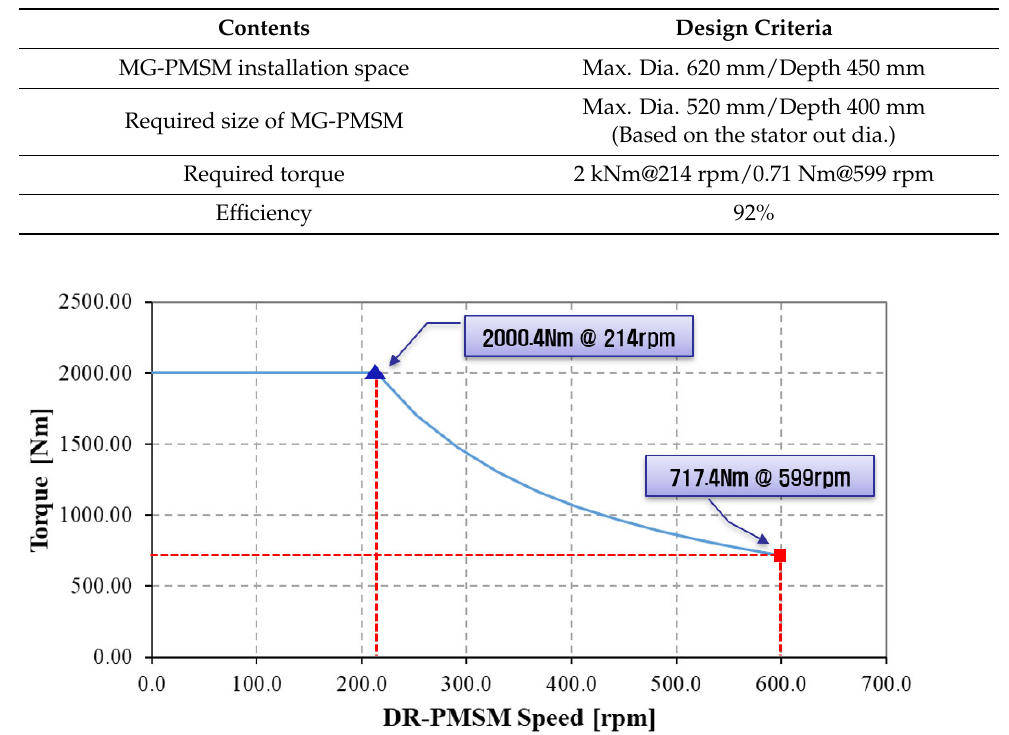
Table 1. MG-PMSM design criteria through installation space analysis.